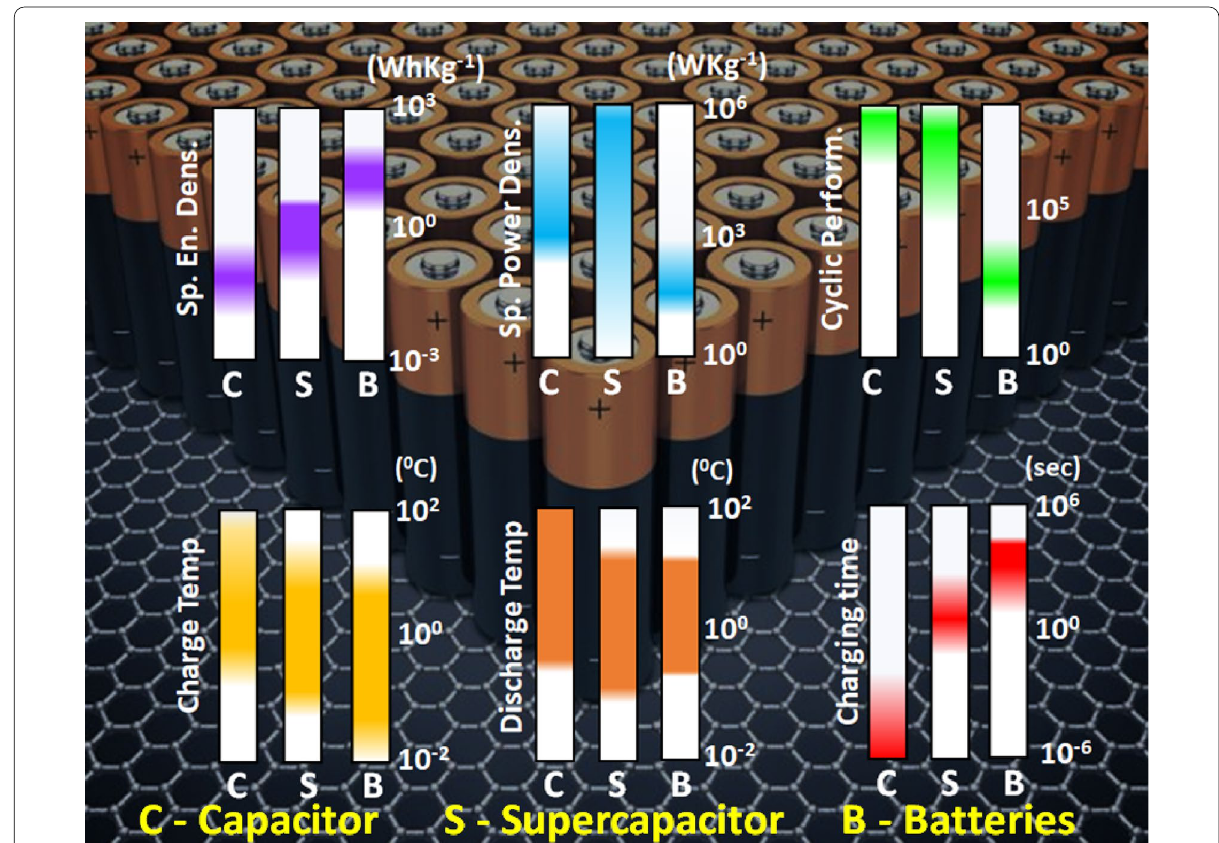
Fig. 12 Summary of critical parameters deciding capacitor, supercapacitor and batteries